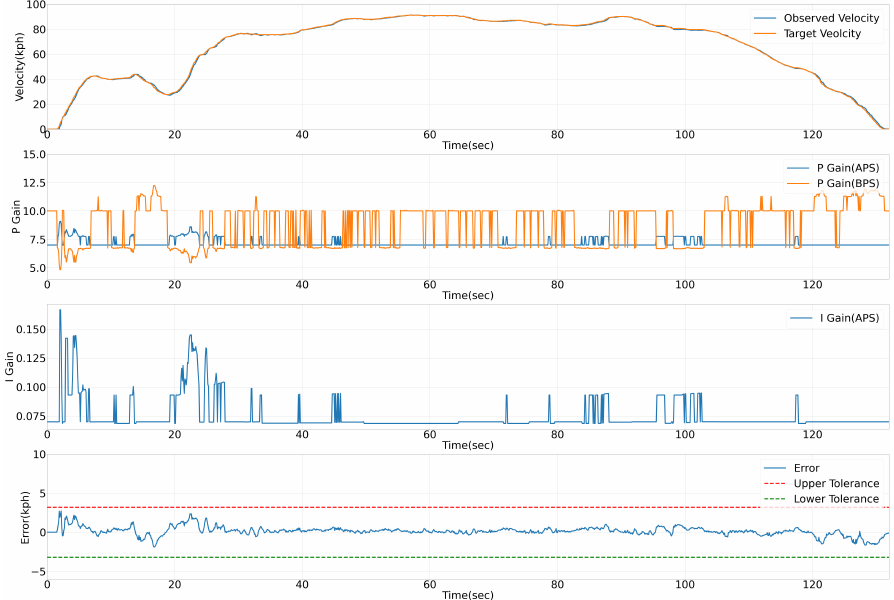
Figure 19. Test Results of the Dynamic Gain Method in Sports